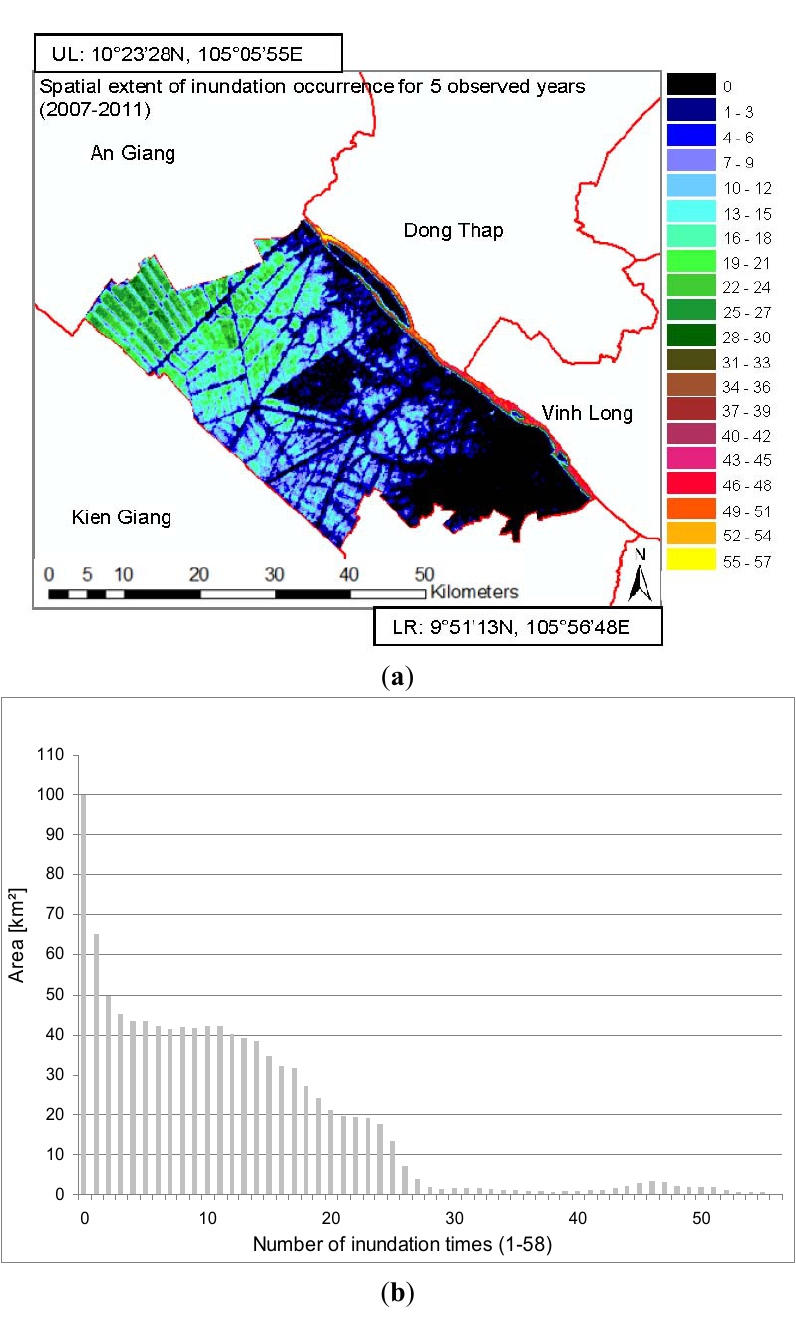
Figure 5. ( a ) Flood water frequency in Can Tho Province for the time span 2007–2011 based on 60 observations of Envisat ASAR-WSM data and flood masks derived thereof. Areas, which are hardly ever inundated (at the observation scale of 150 m resolution) are the settled center of Can Tho city, the distinct rice research farm of the Cuu Long Delta Rice Research Institute, as well as the fruit orchard regions in the Southeast of the province. (b ) Statistics: Flood water frequency for the time span 2007–2011.